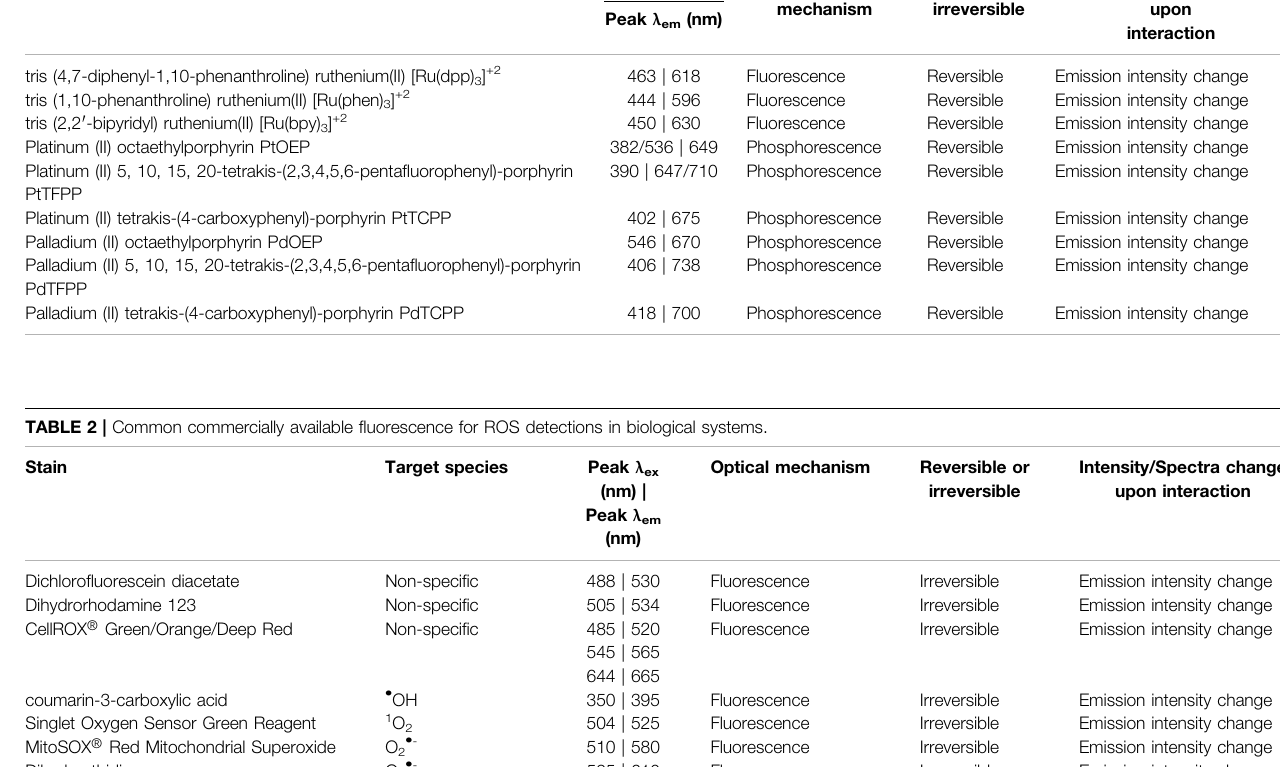
TABLE 1 | Summary of commonly used oxygen-responsive optical dyes for monitoring oxygen levels in biological systems. Optical dye